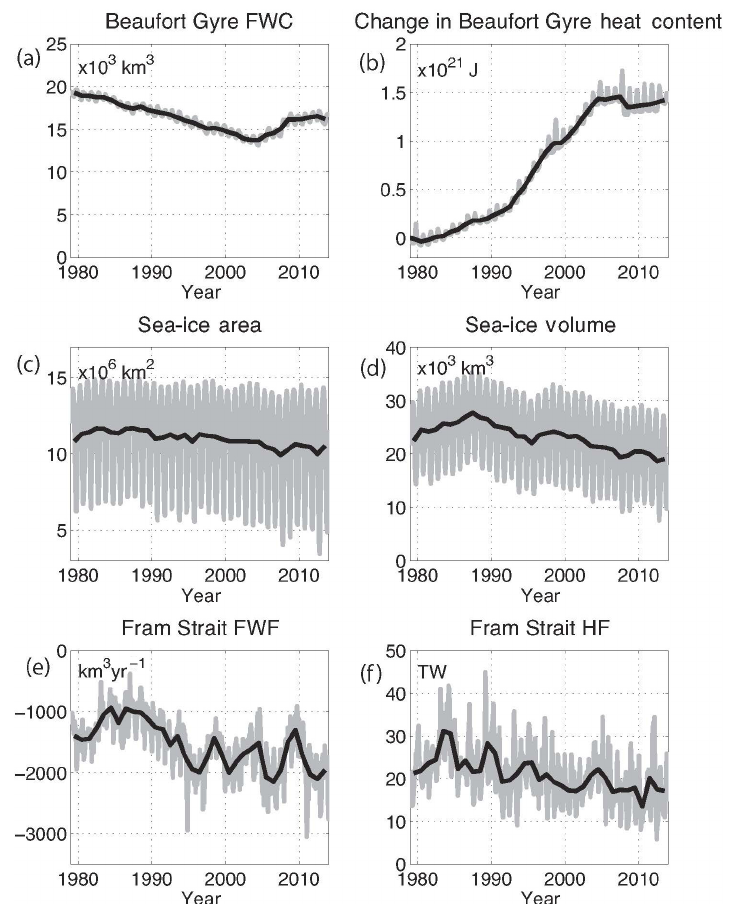
Figure 3. Time series of (a) freshwater content (FWC) and (b) heat content (HC) of the BG, (c) sea-ice area and (d) sea-ice volume over the Arctic, (e) freshwater flux (FWF, negative values imply a flux out of the Arctic), and (f) heat flux through the Fram Strait (HF, positive values indicate a flux in to the Arctic). The thick black line plots annual-mean values; the grey line tracks monthly means. Note that the units of the y axis appear in the top-left-hand corner of each